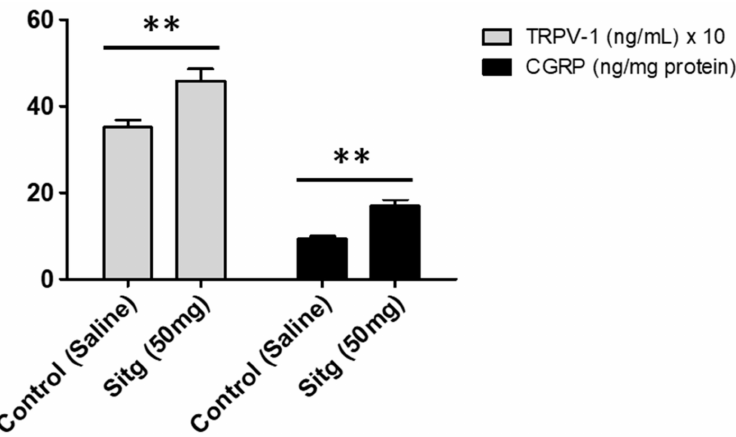
Figure 4. Effect of Sitagliptin treatment on TRPV-1 (expressed in ng/mL) and CGRP (ng/mg protein) ischemic cardiac tissue levels, compared to the Control animal group. A clear significant increase is observed in both proteins levels observed comparing the treated group to the Control (** p < 0.01). Data are illustrated as (Mean ± SEM); ( n = 5–10